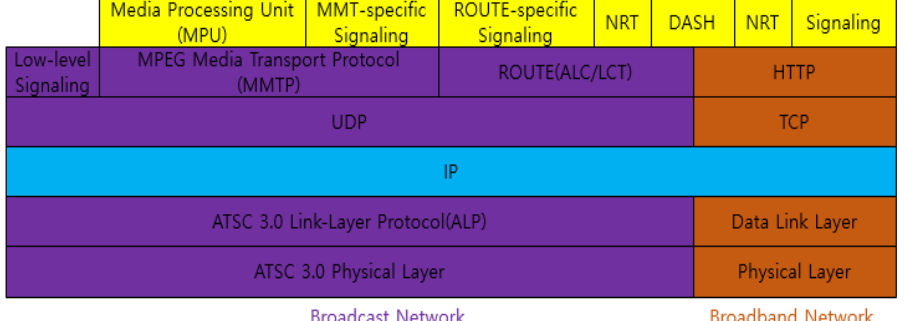
Figure 4. The stack of the IP-based protocol for ATSC 3.0.